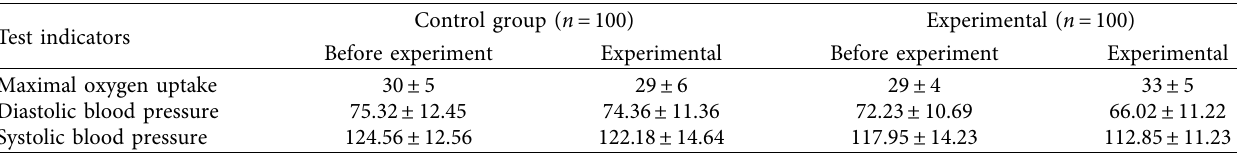
Table 2: The test of cardiorespiratory endurance index of subjects in the control group and the experimental group before and after the